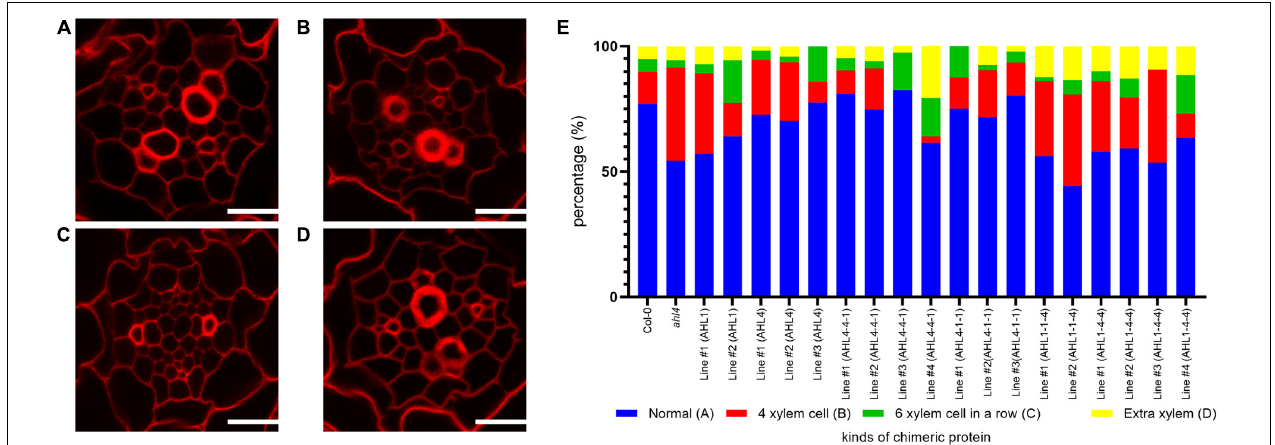
FIGURE 5 | Xylem phenotype recovery by chimeric proteins that are expressed in the stele of the ahl4 mutant: (A–D) Four typical phenotypes of xylem arrangements categorized in the root. Normal phenotype (A) , “four xylem cells” phenotype (B) , “six xylem cells in a row” phenotype (C) , and “extra-xylem” phenotype (D) . Scale bars = 20 µ m. (E) Distribution of the xylem phenotypes of the wild type, ahl4 , and ahl4 expressing each chimeric protein, as categorized in (A–D) . n = 39 ∼ 85. All of the detailed scoring data are presented in Supplementary Table 1